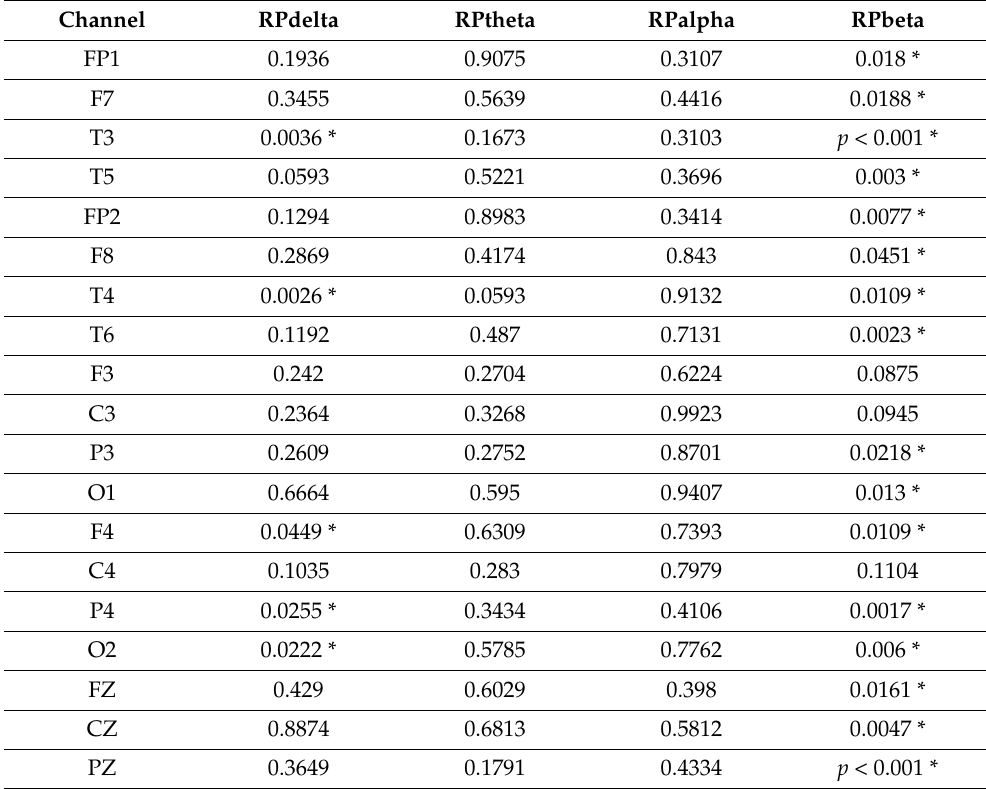
Table 4. Relative power significance test results.